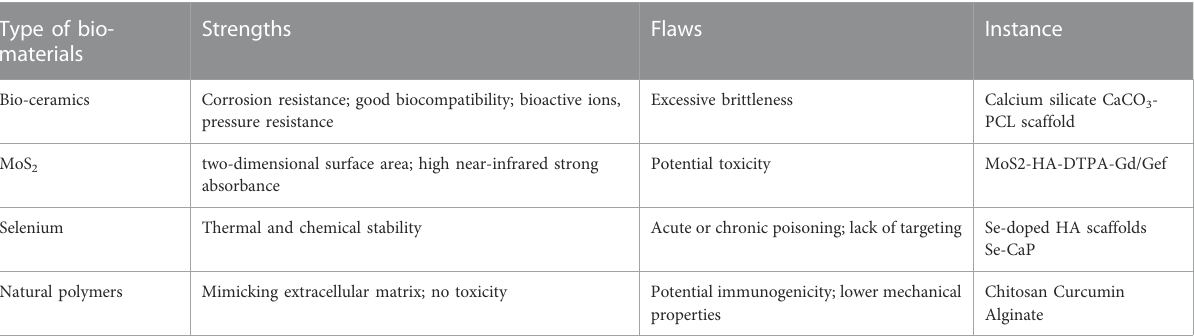
TABLE 2 The main features of other